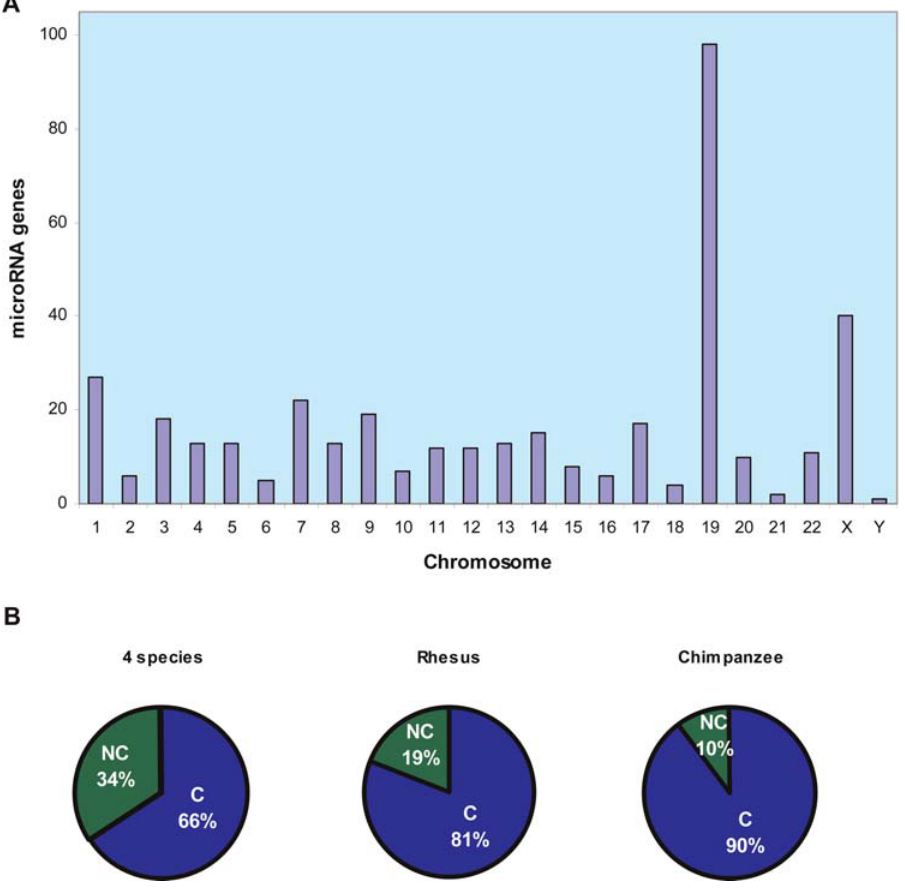
Figure 1. Human embryonic stem cells express 276 miRNAs. (A) 138 hES cell-specific miRNA genes are located on chromosomes 19 and X. Genomic clusters of miRNA were determined by aligning miRNA gene sequences with the human genomic database at Ensemble genome browser by BLAST search (http://www.ensembl.org/Multi/blastview version 41, 2006). Matched chromosome sequences with E values less than 0.01 have been clustered, except specifically marked regions (see Table S1). (B) Evolutionary conservation of hES cell-specific miRNAs. The human genome and genomes of 16 vertebrates (chimpanzee, rhesus monkey, rat, mouse, rabbit, dog, cow, armadillo, elephant, tenrec, opossum, chicken, frog, zebrafish, tetraodon, and fugu) were aligned using the University of California at Santa Cruz Genome Browser (http://genome.ucsc.edu) with the BLAST-Like Alignment Tool (BLAT). C: conserved and NC: nonconserved. Conservation of miRNA genes in 4 species was defined as perfect alignment of at least 3 species among mouse, rat, rabbit, dog and cow (rarely, armadillo, elephant, tenrec or opossum) with a human miRNA sequence. If a miRNA had more than one matched region (repeats) in human chromosomes and only one region was perfectly aligned with other species, it was defined as conserved. Sequence alignments with 2 mismatches or a single mismatch in the miRNA seed region (2–8 nucleotides) were designated as nonconserved (Table S2). miRNA conservation is shown among 4 species, between human and rhesus monkey, and between human and